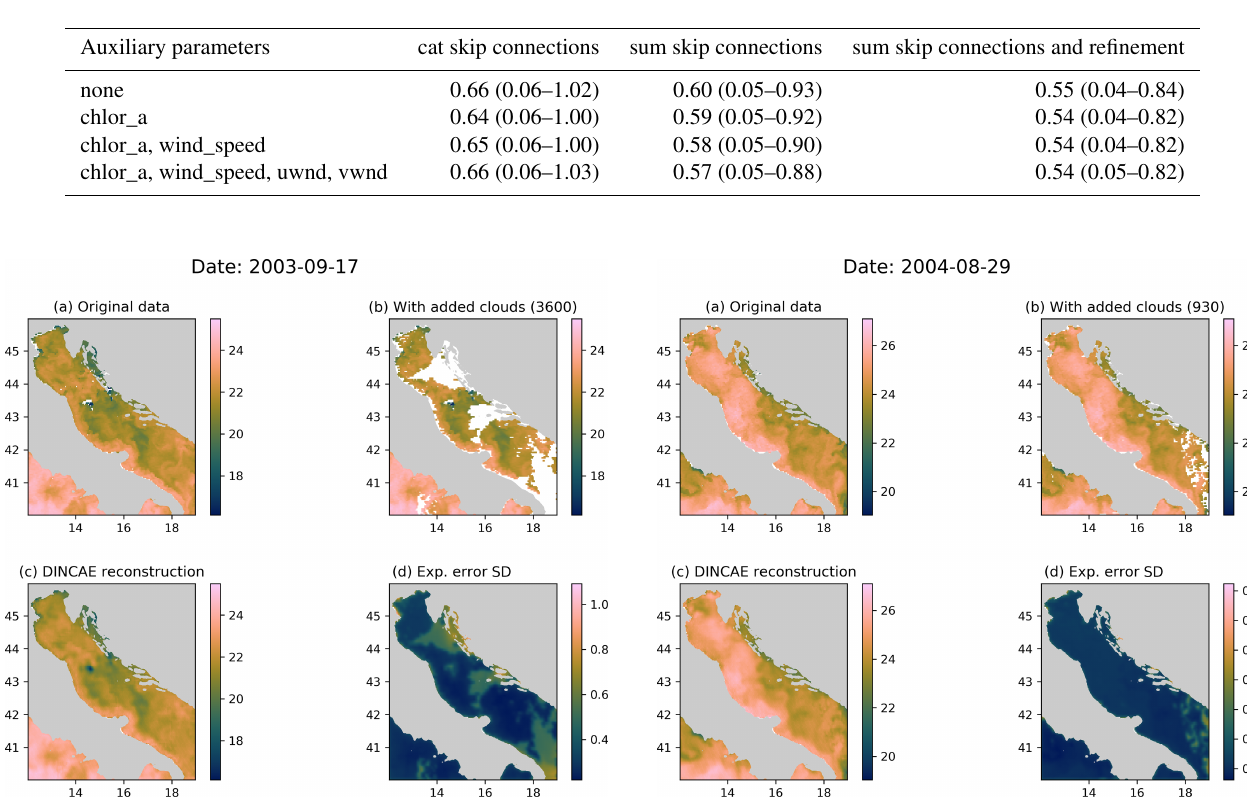
Table 2. RMS errors (in ◦ C) relative to the test dataset for different configurations (chlor_a: chlorophyll a , wind_speed: the wind speed, uwnd: zonal wind component, vwnd: meridional wind component). The two numbers in parentheses correspond to the 10% and 90% percentiles of the absolute value of the error.